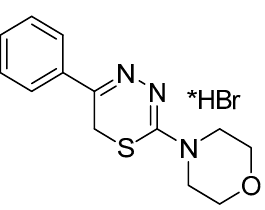
Figure 1. Compound L-17 , a 5-phenyl substituted-6 H -1,3,4-thiadiazine-2-amine.